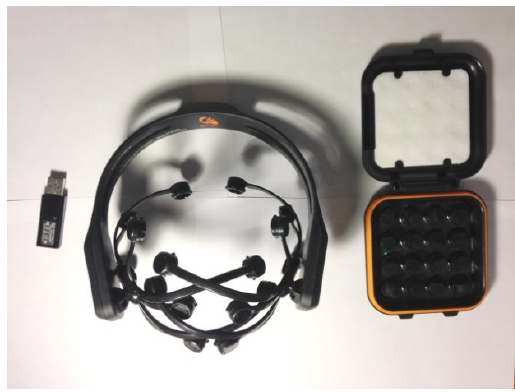
Figure 5. Emotiv EPOC headset: USB Dongle, EPOC headset, and electrodes [57].